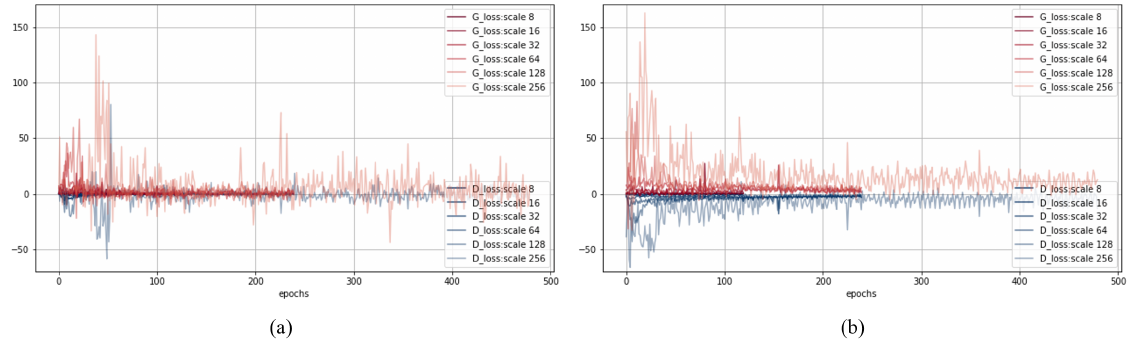
Figure 7. The plots of losses for all resolutions during training: ( a ) PGGAN, ( b ) proposed